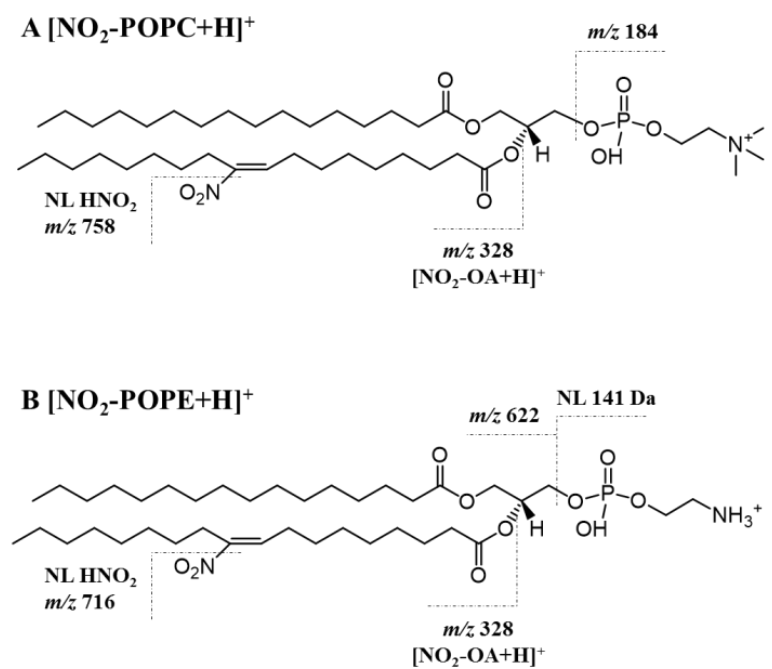
Figure 3. Proposed structure of the (M + H) + ion of nitro POPC ( A , (NO 2 -POPC + H) + ) and nitro POPE ( B , (NO 2 -POPE + H) + ) with the assignment of the major fragmentation pathways of nitrated phospholipids, namely the neutral loss (NL) of nitrous acid (HNO 2 , NL of 47 Da) at m / z 758 for NO 2 -POPC and m / z 716 for NO 2 -POPE, respectively, and the product ions of the modified fatty acyl chain ((NO 2 -OA + H) + ) at m / z 328. The typical fragmentation of the polar head group is also assigned: product ions at m / z 184 for the phosphocholine polar head, and NL of 141 Da for the phosphoethanolamine head group. In these structures the NO 2 is located in C10, but it is not possible to exclude its location in C9.